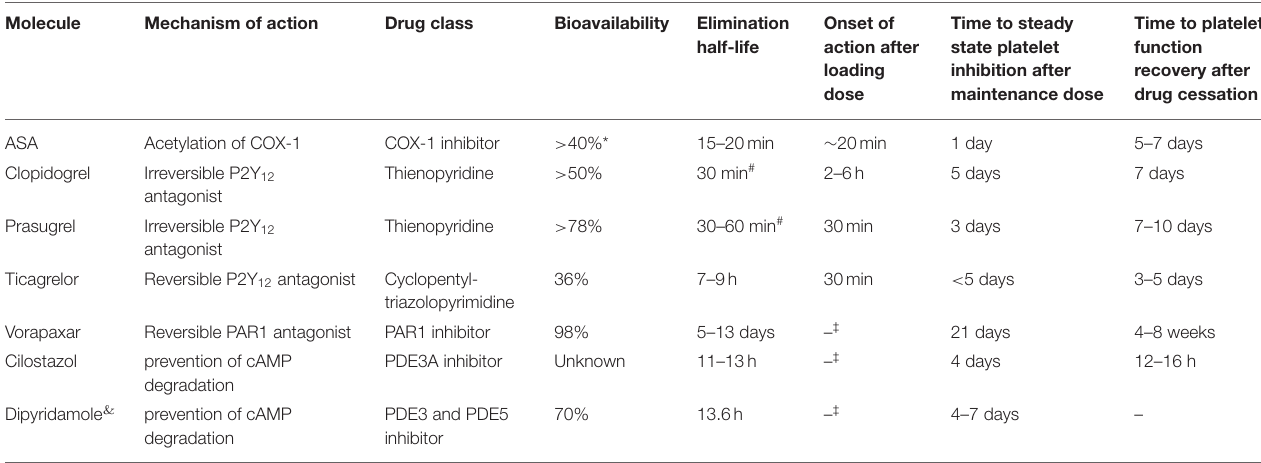
TABLE 1 | Pharmacological characteristics of oral antiplatelet drugs